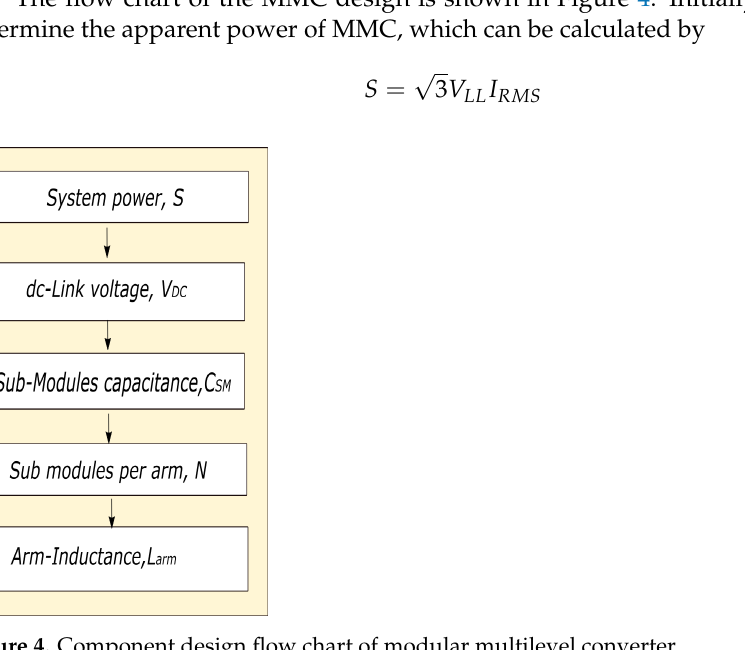
Figure 4. Component design flow chart of modular multilevel